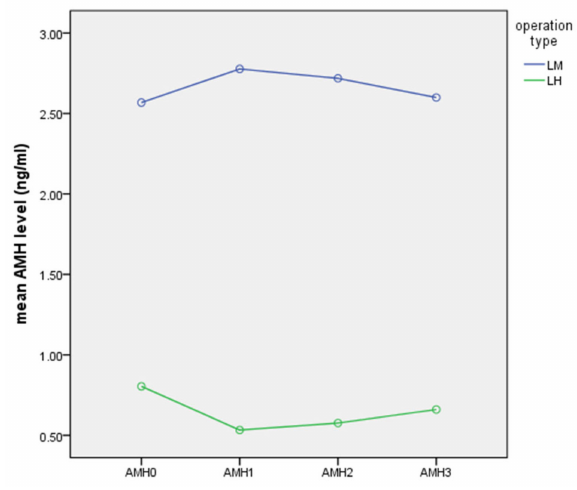
Figure 1. Serial changes in serum AMH following LM or LH (ng/mL).